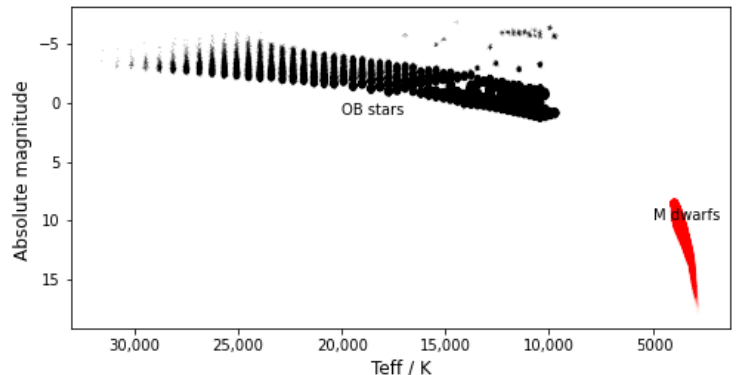
Figure 1. The HR diagram of the sample generated from the Besançon